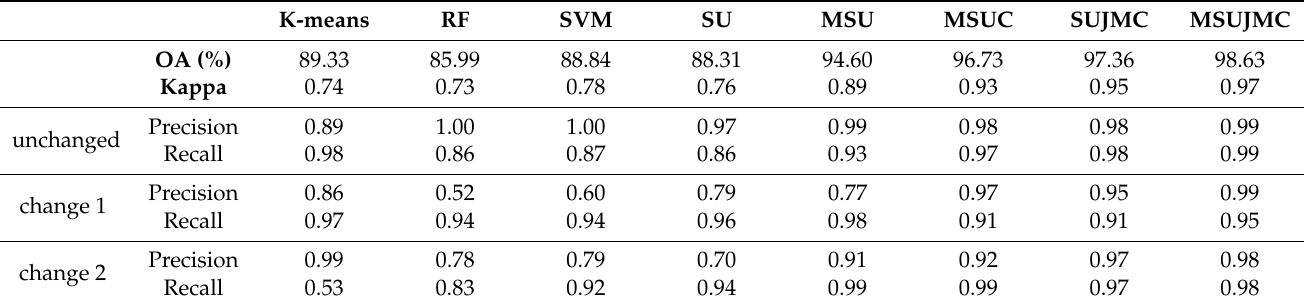
Figure 9. The experimental results of real multitemporal image dataset-1: ( a ) reference image; ( b ) K-means; ( c ) RF; ( d ) SVM; ( e ) SU; ( f ) MSU; ( g ) MSUC; ( h ) SUJMC; ( i ) MSUJMC. Table 3. Accuracy statistics of the real HSI